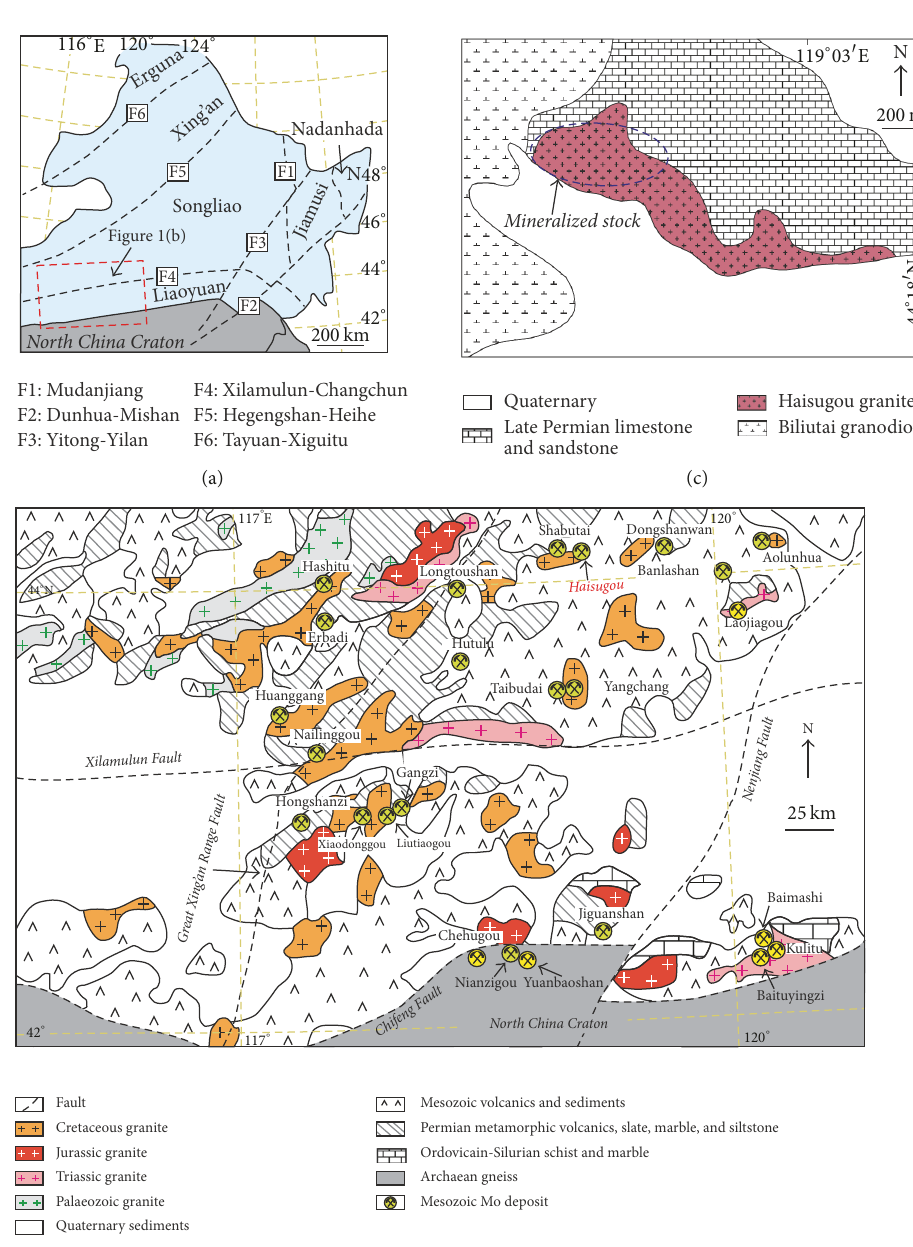
Figure 1: (a) Tectonic subdivisions of northeastern China and location of the Xilamulun district (from Wu et al. [21]). (b) Geological map of the Xilamulun district and the locations of major Mesozoic Mo deposits (from Shu et al. [8]). (c) Simplified geological map of the Haisugou porphyry Mo deposit (from Shu et al.